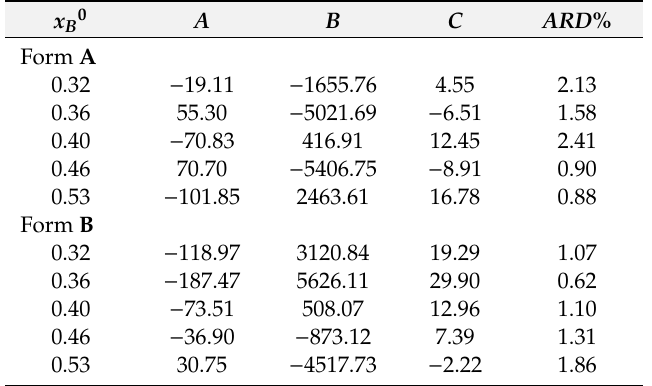
Table 2. Fitting parameters of modified Apelblat model for ethyl acetate + toluene system.